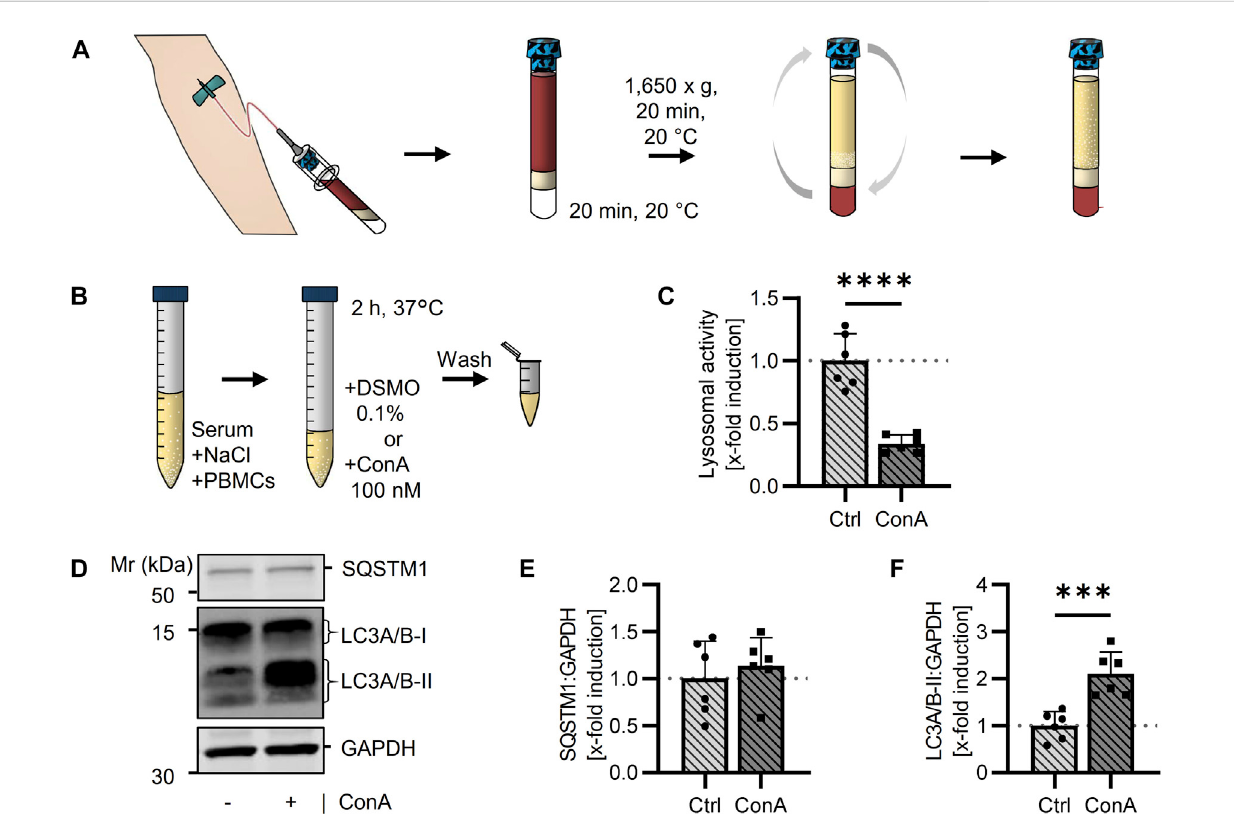
FIGURE 5 Measurement of the autophagic fl ux in isolated human PBMCs using a lysosomal inhibitor. (A) Human blood was taken directly into BD Vacutainer ® with CPT ™ system followed by a centrifugation. PBMCs were dissolved in serum by turning the tube upside down. (B) Collected PBMC cell suspension wassplitinto2samples,eithertreatedwithDMSO(Ctrl)or100 nMConAfor2 hat37 ° C.Afterwashing,cellswereextractedforfollowingexperiments. (C) LysosomalactivitywasdecreasedinConAtreatedPBMCs.ActivitywasmeasuredbyCathepsinBandLmediatedreleaseofAMCafter90 min( n =6). (D) Representative western blot for SQSTM1, LC3A/B-I, LC3A/B-II and GAPDH in control and ConA treated PBMCs. (E) SQSTM1 normalized to GAPDH wasnotaltered byConAtreatment ( n =6). (F) LC3A/B-IIto GAPDHwasincreasedinPBMCstreatedwithConA compared tocontrol cells. Datarepresent mean ± SD. Statistical signi fi cance was tested with t -test and given as follows: *** p ≤ 0.001, **** p ≤ 0.0001. Mr, molecular weight